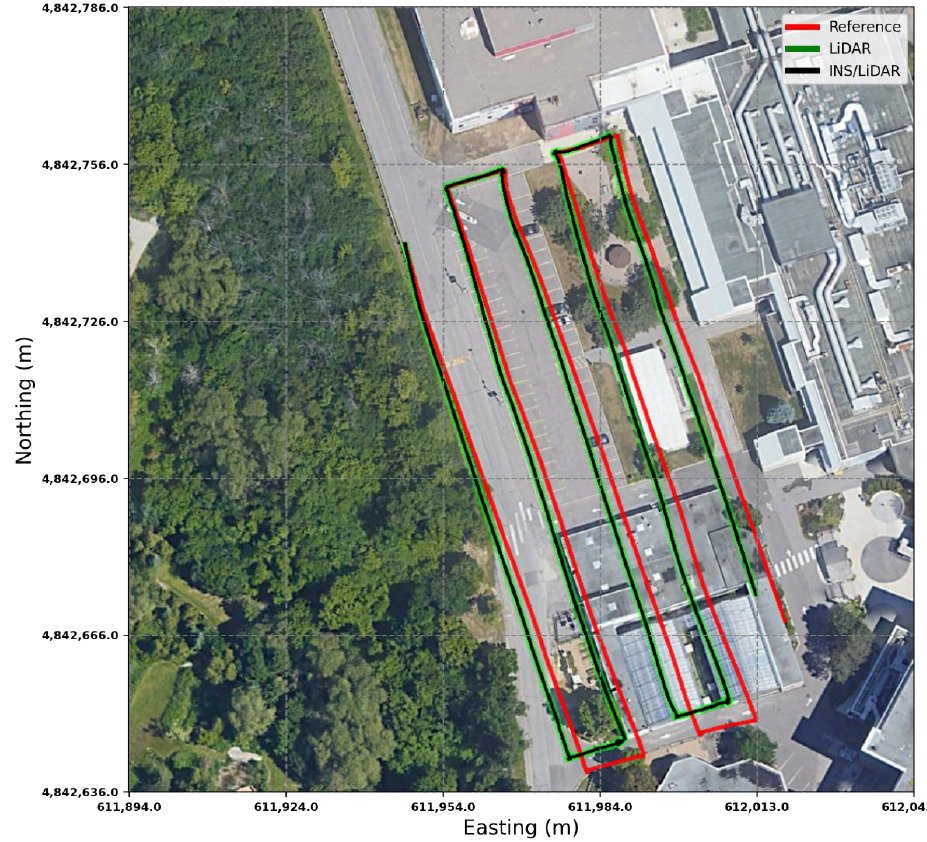
Figure 12. complete GNNS signal outage: comparison of trajectories. Figure 12. Complete GNNS signal outage: comparison of